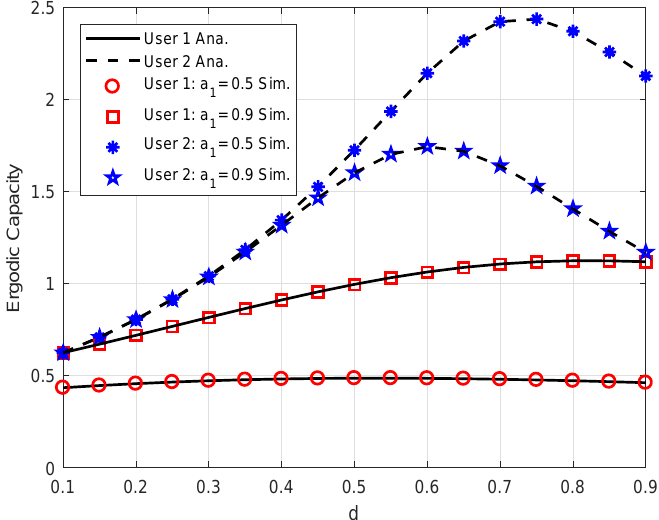
Figure 7. Ergodic capacity of User 1 and User 2 versus